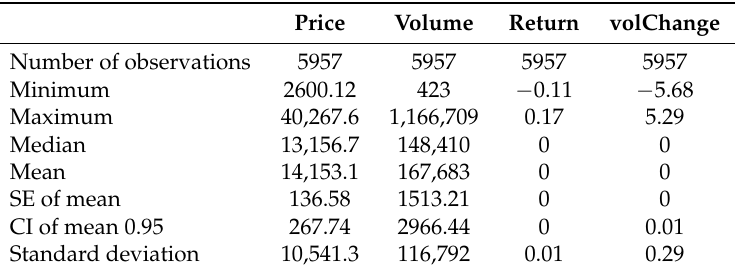
Table 1. Summary statistics of the data.